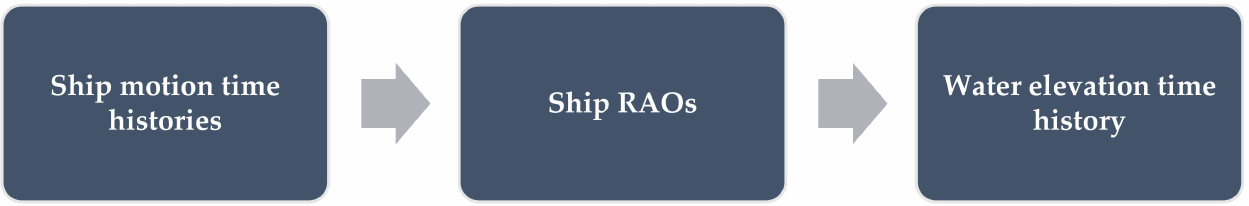
Figure 11. Sea state assessment by time domain analysis.